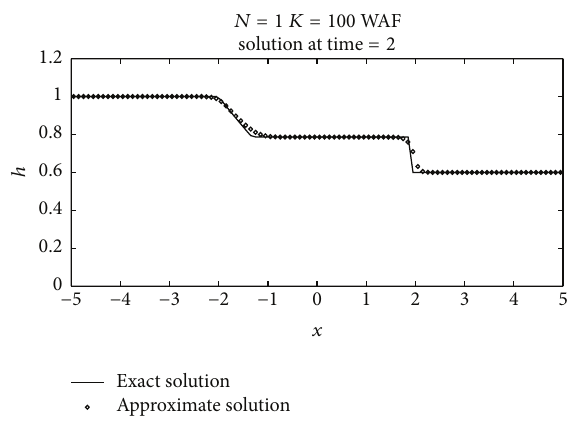
Figure 2: Exact solution and water depth profile obtained by the TVD-RK DG WAF